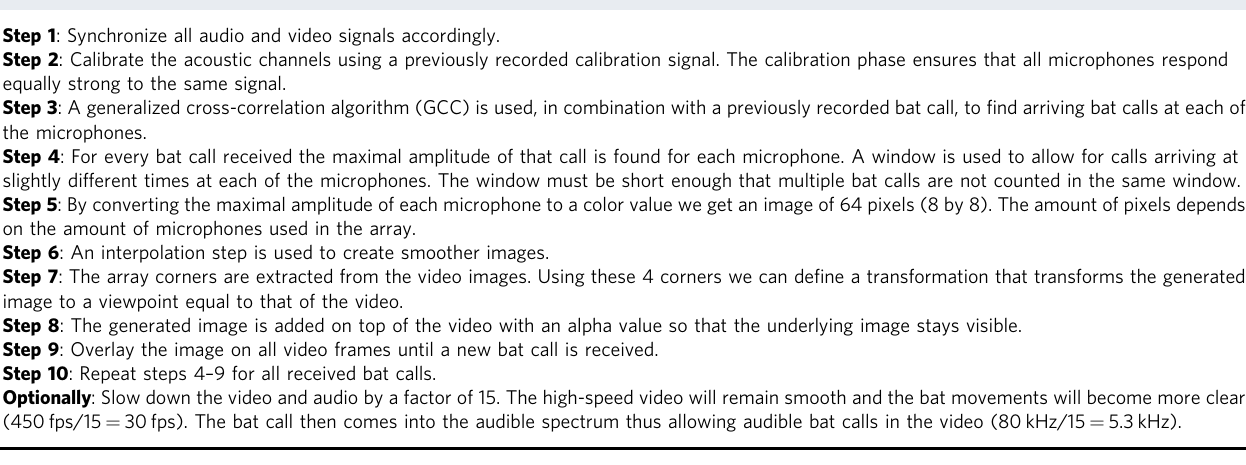
Box 2 | Algorithm used for heatmap generation and video